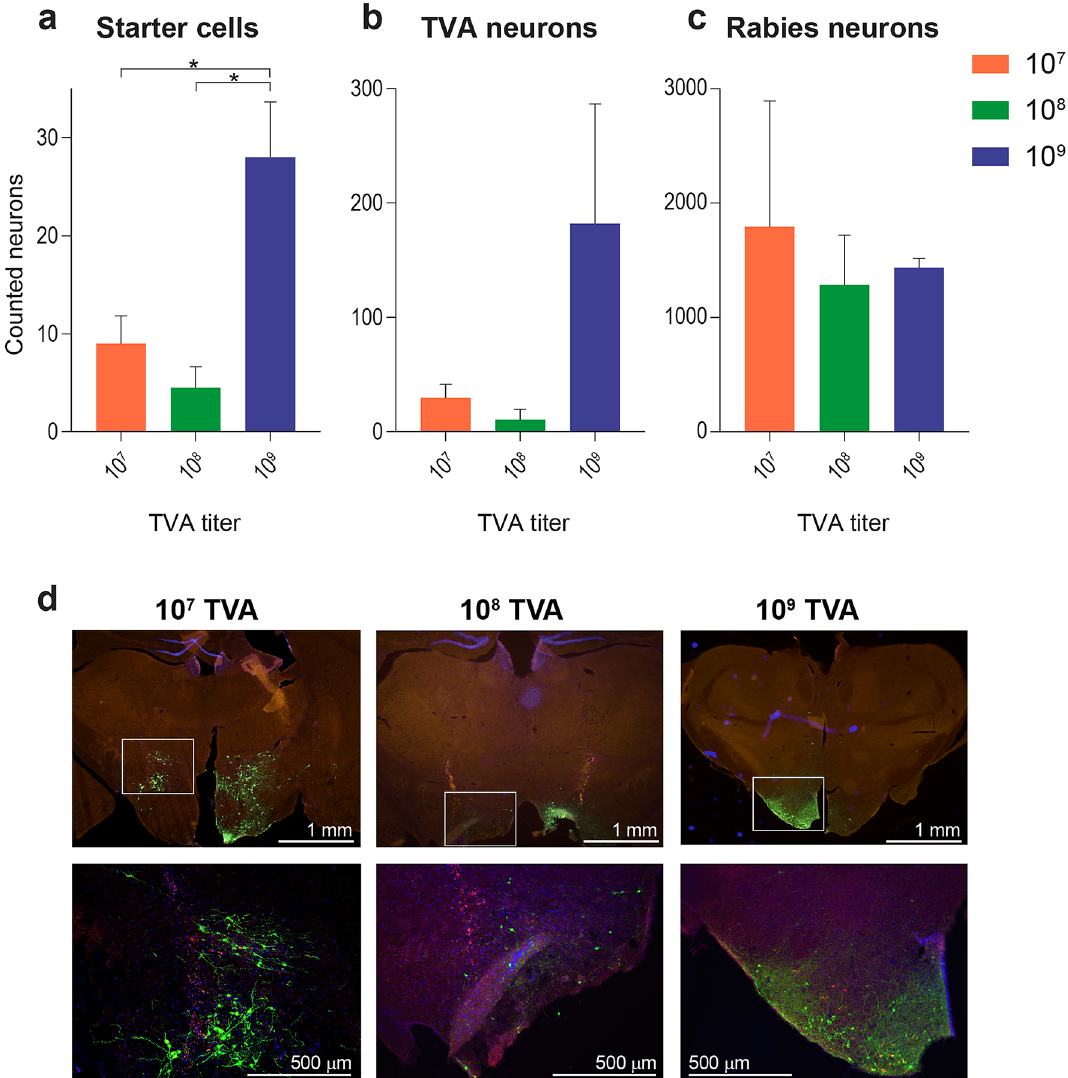
Figure 4. RV d G expression in LepRb-Cre mice. Number of starter cells ( a ), TVA-expressing neurons ( b ), and RV dG -expressing neurons ( c ) were quantified in LepRb-Cre mice that were injected with Cre-dependent TVA and G, followed by SAD-ΔG-eGFP(EnvA) in the LH. ( a ) Number of starter cells increased significantly with TVA titer [ F (2,3) = 20.98, p = 0.017]. Post hoc comparison using Tukey HSD test showed that a TVA titer of 1 × 10 9 g.c./µl [28 ± 5.66] resulted in significantly more starter cells than TVA titers of 1 × 10 7 g.c./µl [9 ± 2.83] or 1 × 10 8 g.c./µl [4.5 ± 2.12]. ( b ) TVA-expressing neurons showed a trend towards an increase with TVA titer [ F (2,3) = 4.743, p = 0.118]. ( c ) No difference was found in the number of RV dG -expressing neurons [ F (2,3) = 0.293, p = 0.765]. ( d ) These results are also visible in the representative images with zooms per titer underneath. For the 2.5 × images: 3.953 µm/pixel, and for the 10 × zooms: 1.018 µm/pixel. Note that injections of 1 × 10 7 g.c./µl and 1 × 10 8 g.c./µl rAAV5-Flex-TCB were done bilaterally, whereas 1 × 10 9 g.c./µl rAAV5-Flex-TCB was done unilaterally. Further, note that the y-axes are ten-folds different for a , b , and c . Initial version of graphs in a , b , and c was created using GraphPad Prism (version